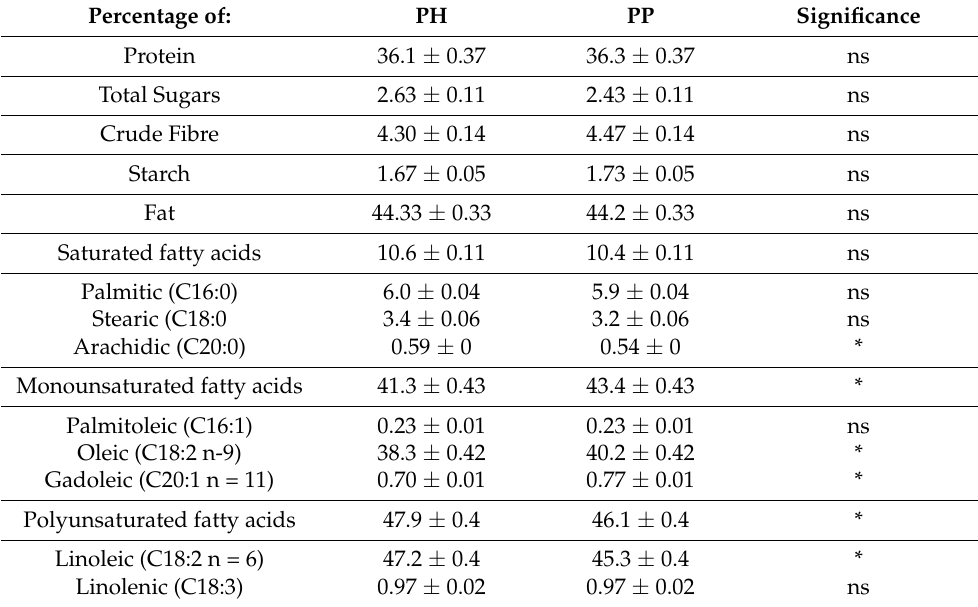
Table 3. Chemical composition of pine nuts from grafted stone pine onto P. pinea (PP) and P. halepensis (PH). Mean ± standard error and results of statistical analysis ( p <